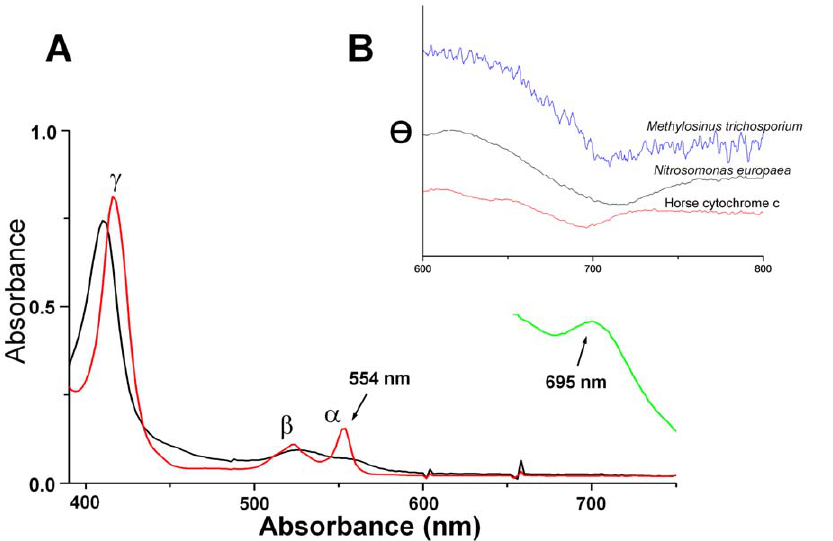
Figure 1. Absorption and CD spectra of cytochrome c -554 from Methylosinustrichosporium OB3b. A. Visible absorption spectra of a 7 m M solution of the reduced and oxidized cytochrome c -554 from Methylosinus trichosporium OB3b. The a -band in the reduced spectrum has a maximum at 554 nm used to name the cytochrome. The spectrum of a 83 m M solution of the oxidized protein exhibits a peak at 695 nm in the oxidised spectrum is indicative of methionine ligation to the heme. B. Circular dichroism of a 60 m M solution of cytochrome c -554 (magnified 10 times) is compared with a 790 m M solution of cytochrome c -552 from Nitrosomonas europaea and a 200 m M solution of cytochrome c from horse heart. The circular dichroism at the methionine peak shows that the cytochrome c -554 has stronger similarities with cytochrome c -552 from Nitrosomonas europaea than cytochrome c from horse heart.